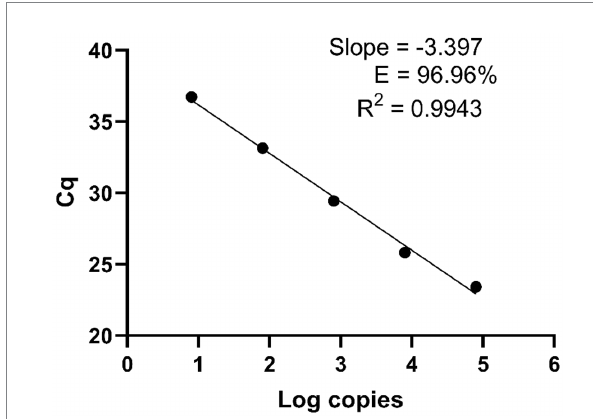
FIGURE 1 The Bmer-qPCR against 10-fold serial dilutions of the B. miyamotoi FR64b DNA to measure the PCR efficiency. Cq values were plotted against the log values of serial dilutions of the FR64b DNA. Simple regression analysis was carried out using the Graphpad Prism 8.4.3 software. The slope, coefficient of correlation ( R 2 ) and efficiency of the reaction (E) are shown. Each dot represents the average value from triplicate amplifications, along with the SD.